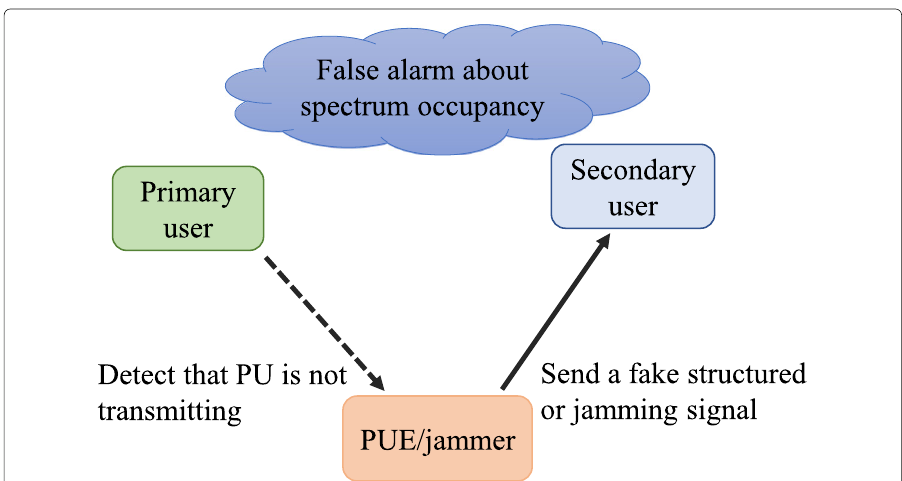
Fig. 1 The basic system model: a PUE and a jammer want to degrade SU’s spectrum utilization by sending fake